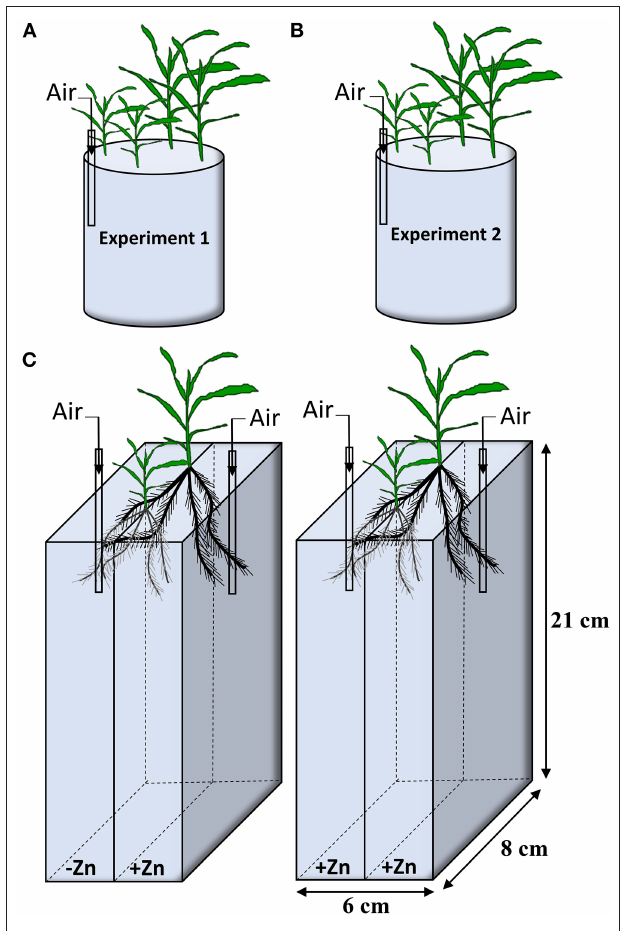
FIGURE 1 | Experiment design in this study. (A) In Experiment 1, two plants of inbred lines Wu312 and Ye478 were mix-cropped in a 3.3-liter container. Seven different EDTA-Zn levels (0, 0.05, 0.1, 0.2, 0.4, 0.5, 8 µ M) were set up. (B) In Experiment 2, two seedlings of each inbred line were grown at eight different Zn nutritional status (0, 0.5, 1, 2, 4, 8, 16, 32 µ M EDTA-Zn). (C) Two-compartment container was used in Experiment 3. Each seedling of Wu312 and Ye478 was grown hydroponically in mix-cropping under split Zn supply [0.5 µ M for Zn-deficient condition (–Zn) and 8 µ M for Zn-sufficient condition ( + Zn)]. There were three replicates in Experiment 1 and 2, and four replicates in Experiment 3. Each experiment was continuously